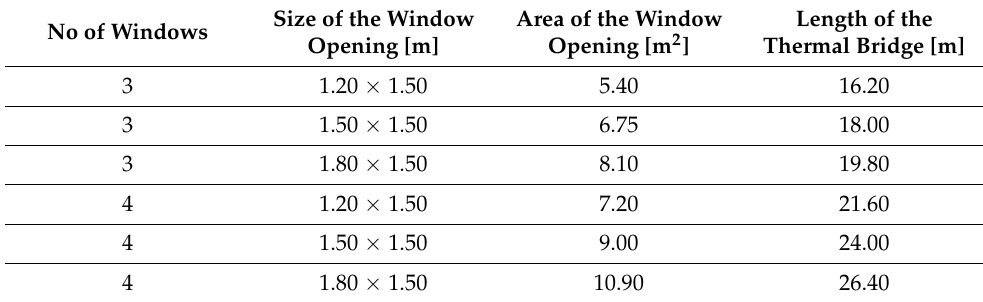
Table 5. Parameters of the windows facing